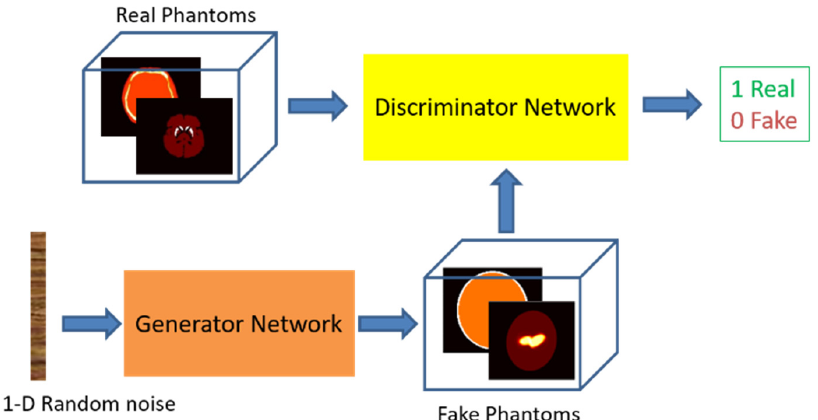
Figure 2. The training scheme of GAN for generating numerical brain phantoms for the PET/SPECT PD study. Each phantom is composed of two images: one representing the radiopharmaceutical distribution in the brain and the other representing a corresponding attenuation map. The fake phantoms denote the generated image.